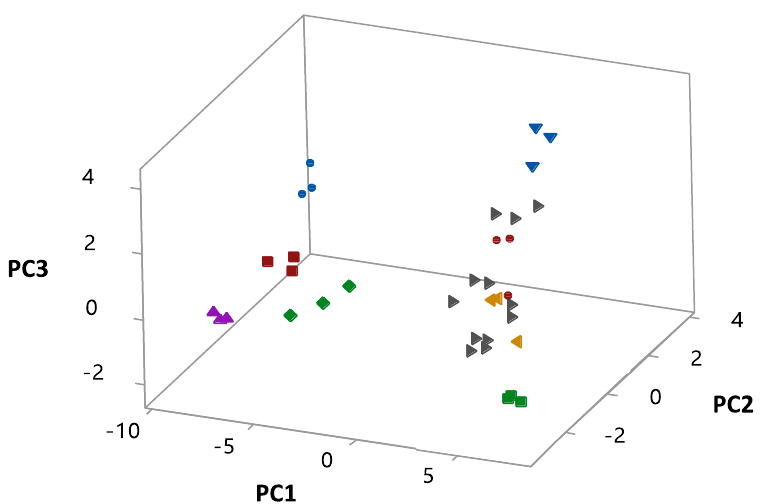
Figure 5. Growth conditions associated with biological answers illustrated by components 1 (expo- nential cell growth), 2 (cell growth in the lag phase) and 3 (BLIS production). Runs: ( ■ ) 1; ( ▼ ) 2; ( ▲ ) 3; ( ■ ) 4); ( ● ) 5; ( ◄ ) 6; ( ⧫ ) 7; ( ● ) 8; ( ► ) Central runs.